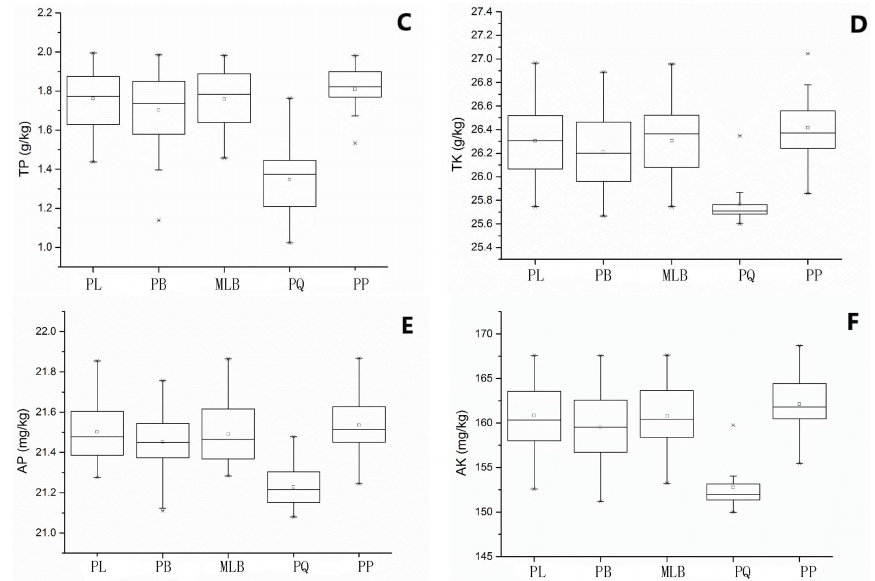
Figure 2. Variation of soil properties in different forest types. SOC = soil organic carbon, TN = total nitrogen, TP = total phosphorus, TK = total potassium, AP = available phosphorus, and AK = available potassium. PP = pure Pinus sylvestris L. var. mongolica Litv. forest, PQ = pure Quercus mongolica Fisch . ex Ledeb. forest, MLB = Larix gmelinii (Rupr.) Kuzen and Betula platyphylla Suk. mixed forest, PL = pure Larix gmelinii (Rupr.) Kuzen forest, PB = pure Betula platyphylla Suk. forest. A , B , C , D , E and F were respectively represent for SOC, TN, TP, TK, AP and AK content of five forest types. “ (cid:3) ” = average value, “ × ” = outliter.